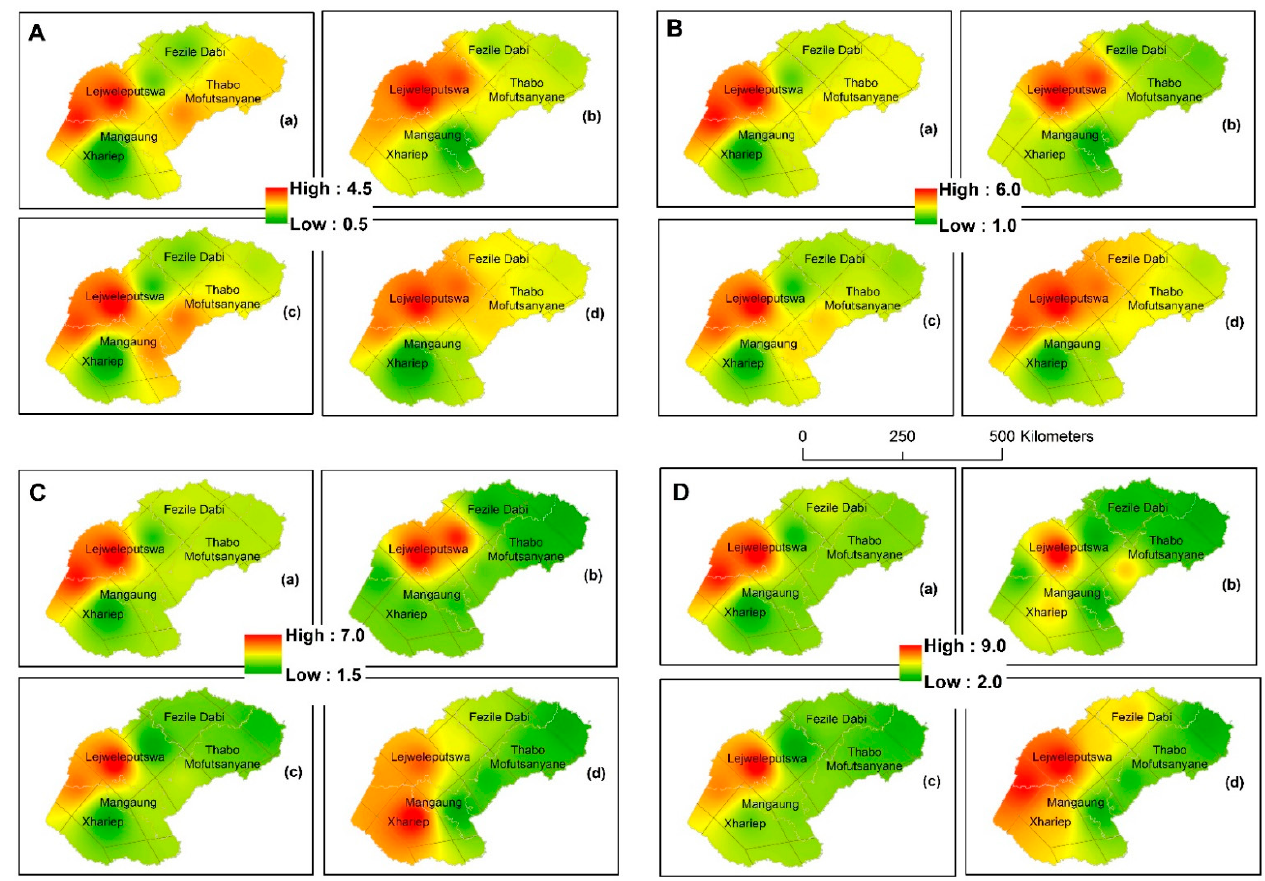
Figure 8. Spatial distribution of the drought severity return levels for the 5- (a), 10- (b), 20- (c), and 50-year (d) return periods, over the Free State Province from 1980 to 2019: ( A ) EDI; ( B ) SPI-3; ( C ) SPI-6; ( D ) SPI-12.